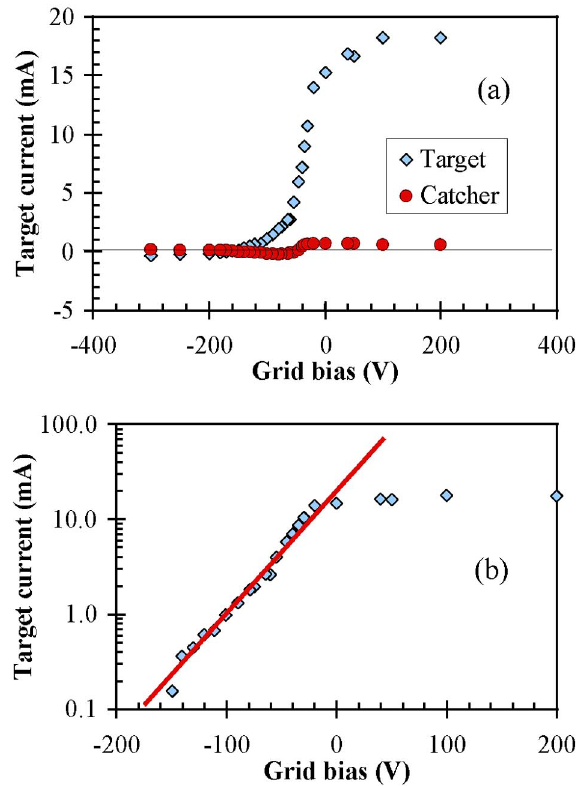
FIG. 5. (Color) The bias voltage of the grid is varied, one shot at each bias, while maintaining the target at (cid:10) 40 V and an angle of 80 (cid:1) from normal incidence, the suppressor at (cid:10) 200 V and the catcher at (cid:10) 45 V . A grid bias more positive than the target by 90 V is sufficient to obtain reliable target electron emission current. (a) The target current (blue diamonds) and catcher current (red circles) displayed on a linear scale and (b) the target current is displayed on a log scale for ease in comparing with a 30 eV exponential fit (red